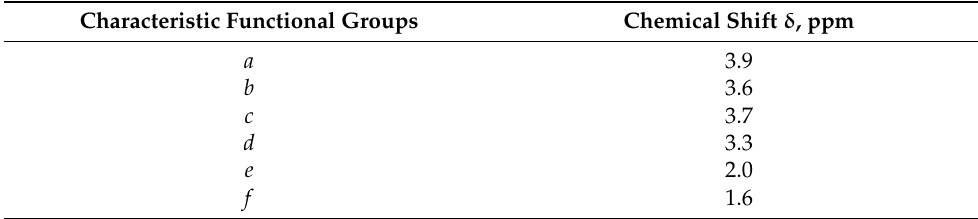
Table 1. 1 HNMR analysis of the copolyether.